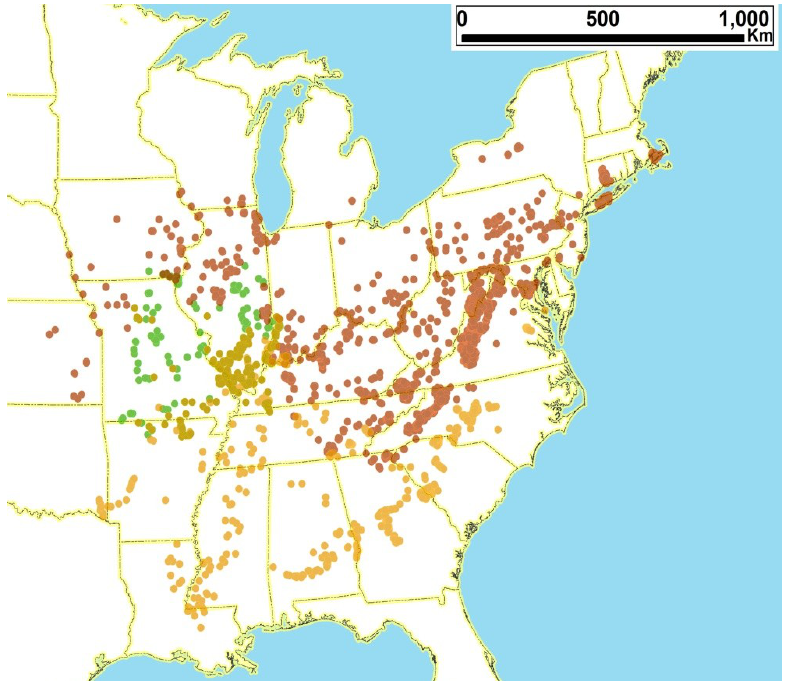
Figure 32. Distribution of Magicicada septendecim (brown circles), M. tredecim (gold circles) and M. neotredecim (green